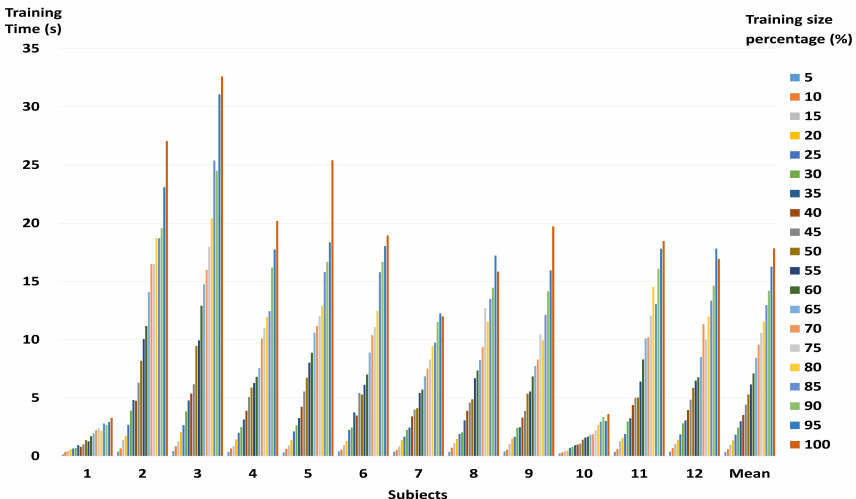
Figure 4. Computation time for training procedure based on reduction rate of whole training data on individual